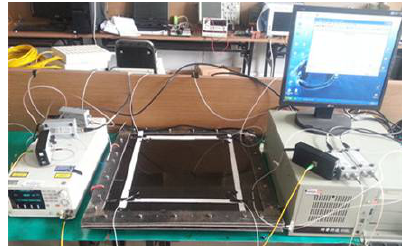
Fig. 2 AE localization experiment system.